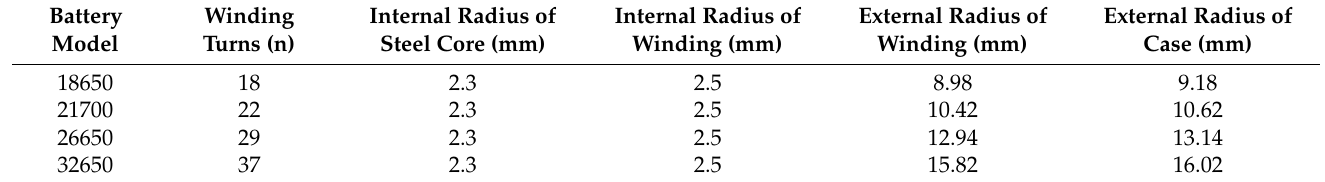
Table 2. The geometric parameters of four types of batteries.